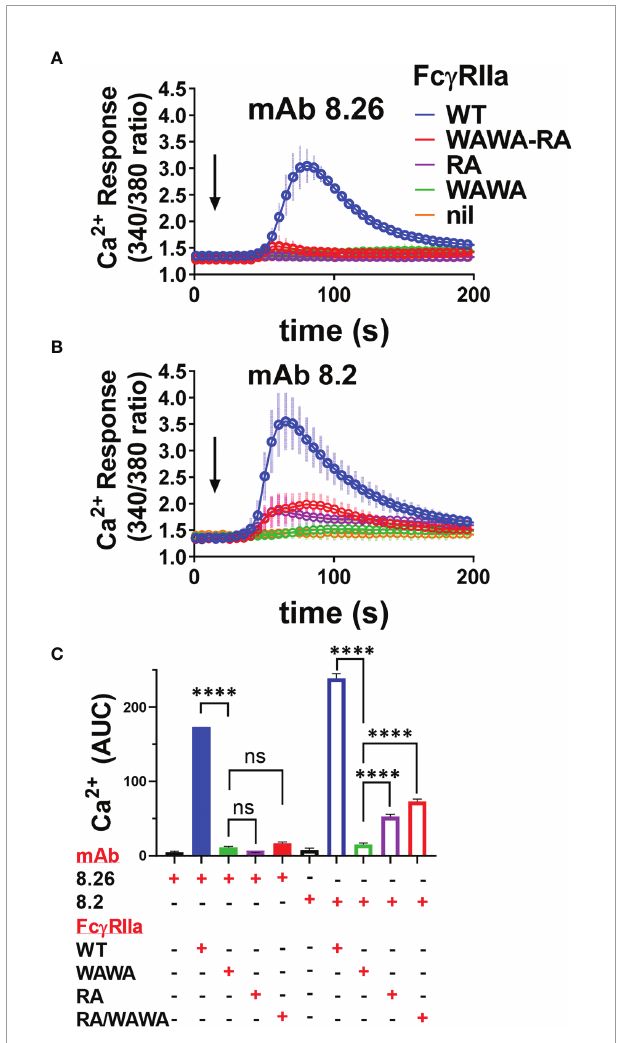
FIGURE 7 | Calcium mobilisation in mAb treated Fc g RIIa expressing cells is not effectively rescued in Fc g RIIa-WAWA/Fc g RIIa-RA co-expressing cells. Fura-2 loaded IIA1.6 cells lacking receptor (nil), or expressing Fc g RIIa-WT, Fc g RIIa-WAWA, Fc g RIIa-RA or co-expressing Fc g RIIa-WAWA and Fc g RIIa-RA (WAWA-RA) were treated with (A) agonist mAb 8.26, 20 µg/ml (n = 5, 340/ 380nm FI ± SEM) or (B) 8.2, 10 µg/ml (n = 3-5, ± SEM). (C) Area under curve analysis of Ca 2+ mobilisation in (A, B) with 1-way ANOVA with Dunnett ’ s multiple comparison test showing comparison to Fc g RIIa-WAWA, ****p <